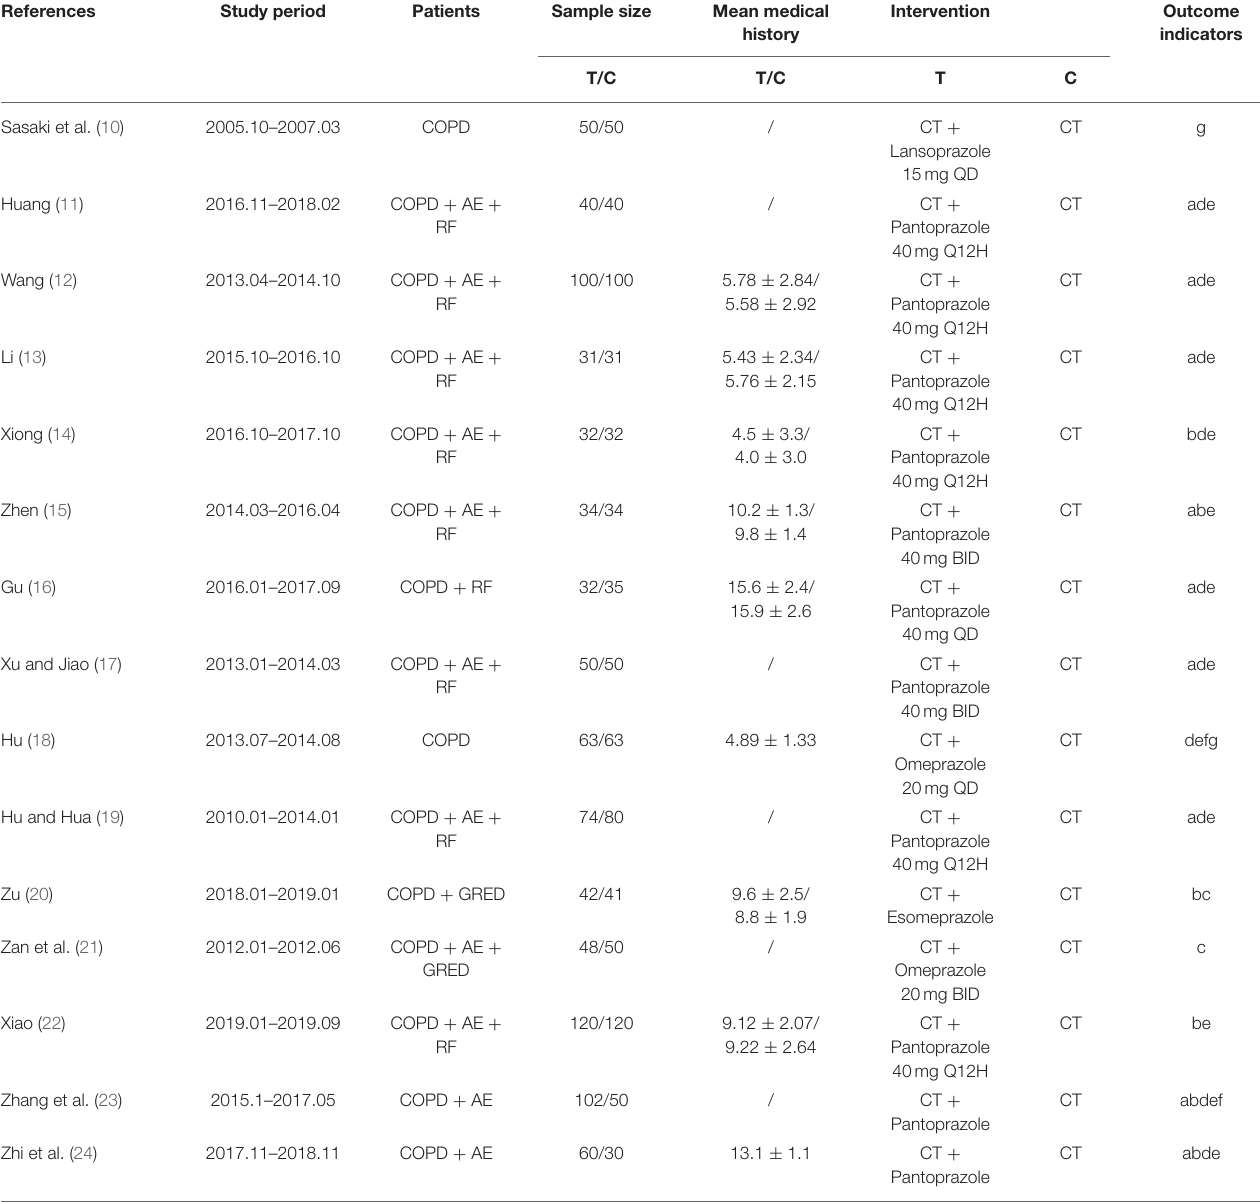
TABLE 1 | The basic characteristics of involved